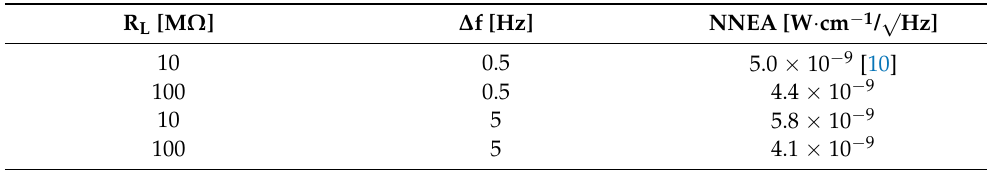
Table 2. NNEA for different values of R L and ∆ f, calculated starting from the value reported in [10] for the detection of CO 2 in an N 2